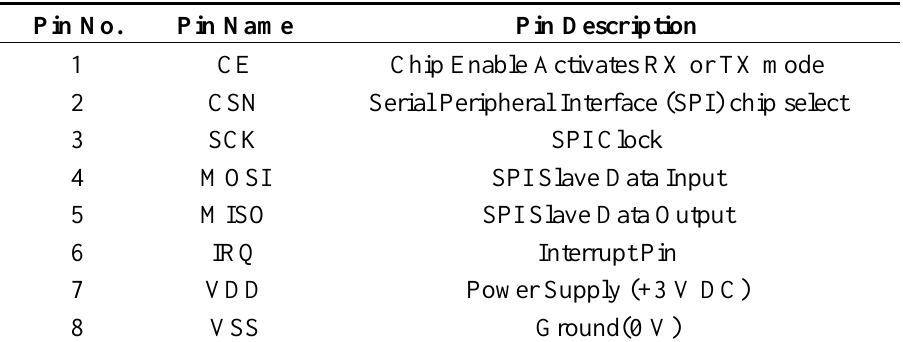
Table 4. Pins description of nRF24L01